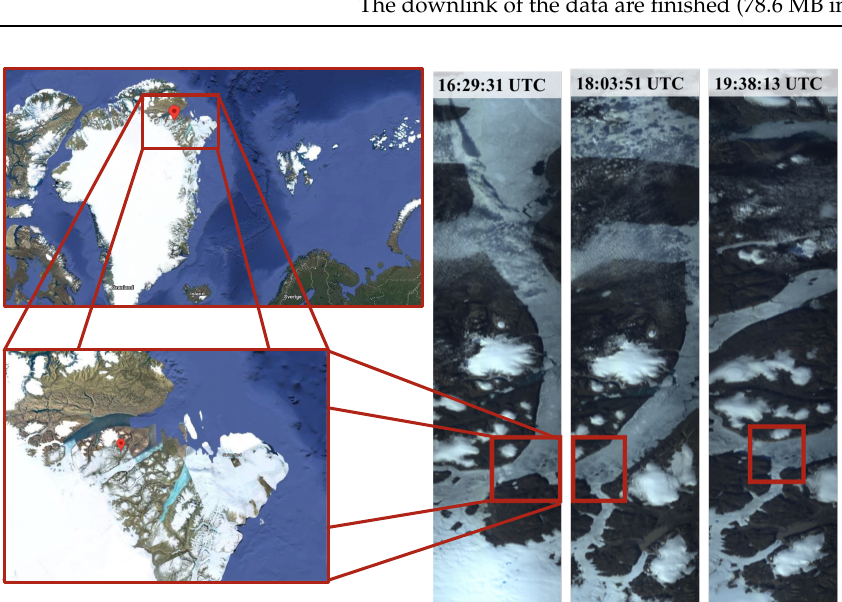
Figure 3. RGB render of three consecutive HYPSO-1 captures over Greenland (81.7°N, 27.3°W) on 16 August 2022. The wavelengths used to represent Red, Green and Blue are 603, 565 and 498 nanometers, respectively. The images on the left hand side zooming in on the target area are taken from Google